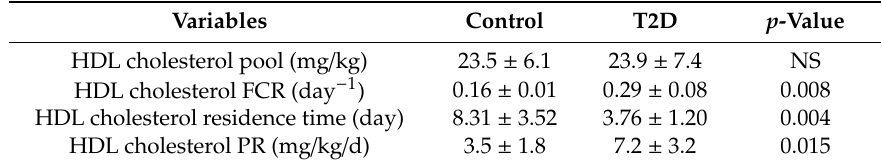
Table 2. High-density lipoprotein (HDL) cholesterol kinetic parameters in subjects with T2D (n = 9) and age- and body mass index (BMI)-matched healthy controls (n = 8).